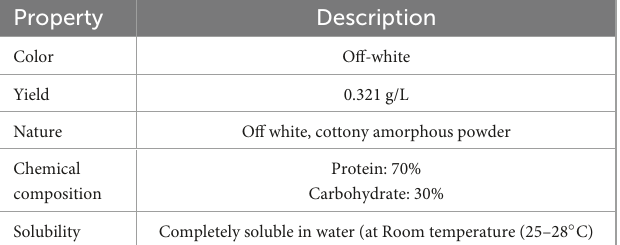
TABLE 2 Properties of bioemulsifier produced by Parapedobacter indicus.